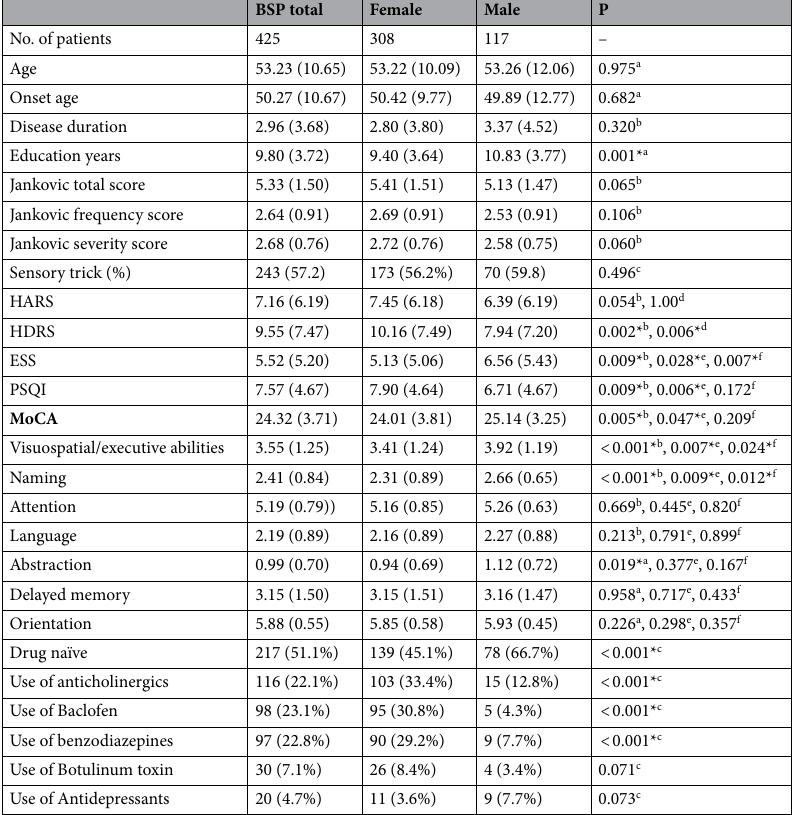
More female patients were under treatment of trihexyphenidyl, baclofen and benzodiazepines, while more male patients were newly diagnosed and drug naïve. Sex-related differences in NMSs severities and distributions in BSP patients. The prevalence of NMSs in the total BSP cohort and according to sex is shown in Table 2. In the total BSP patients, the mean (± SD) number of NMSs was 2.9 ± 1.5 (range 0–6), 78.6% of patients complained at least two NMSs and only 4.7% of patients were found to be free of NMSs. Compared with male patients, female patients showed significant higher scores of HDRS, but lower scores of ESS, visuospatial/executive abilities and naming subdomains of MoCA, with and without adjustment of con- founding factors (Table 1). Female patients had significantly higher PSQI score and lower global MoCA score than male patients, and the differences remain significant after adjusting confounding factors including age, education years, disease duration, Jankovic total score, use of benzodiazepines and anticolinergics, but did not survive after adjusting HDRS score (p = 0.230 for PSQI, p = 0.088 for MoCA) or adjusting both HDRS and HARS scores (p = 0.172 for PSQI, p = 0.209 for MoCA) additionally (Table 1). Female patients complained significantly more frequently than male patients of having depression (p = 0.005) and cognitive dysfunction (p < 0.001), while less prevalent in EDS (p = 0.037) (Table 2). No significant differences were found between female and male patients in the HARS scores, or in the frequency of anxiety or ocular disturbances. As regards domains, 76.9% patients had more than one domain of NMSs involved, and female patients pre- sented significant higher prevalence of more multiple nonmotor symptom domains affected than male patients (p = 0.040) (Table 2).